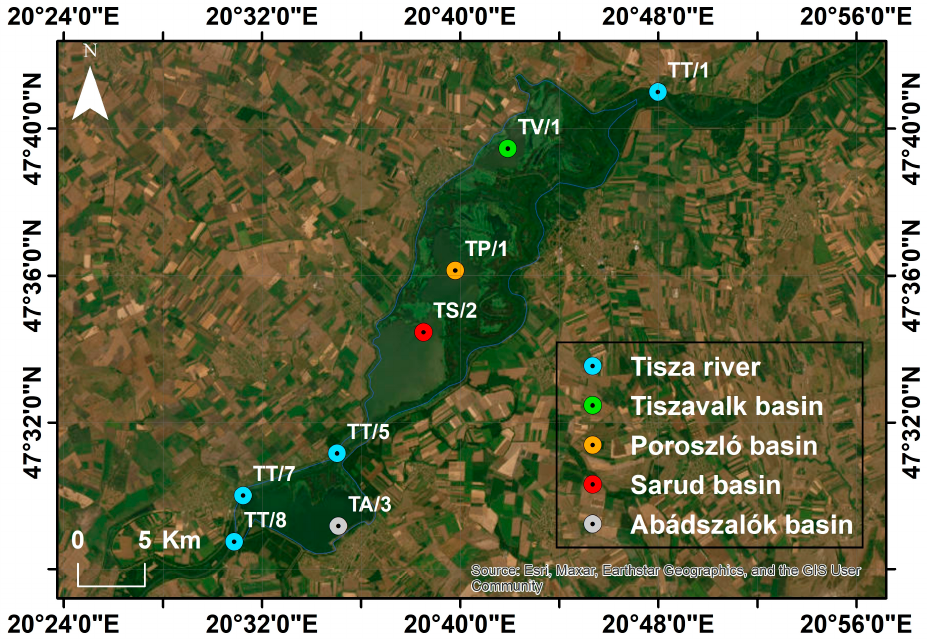
Figure 3. Location of the sampling points in the Tisza River section and in the different basins of the lake.